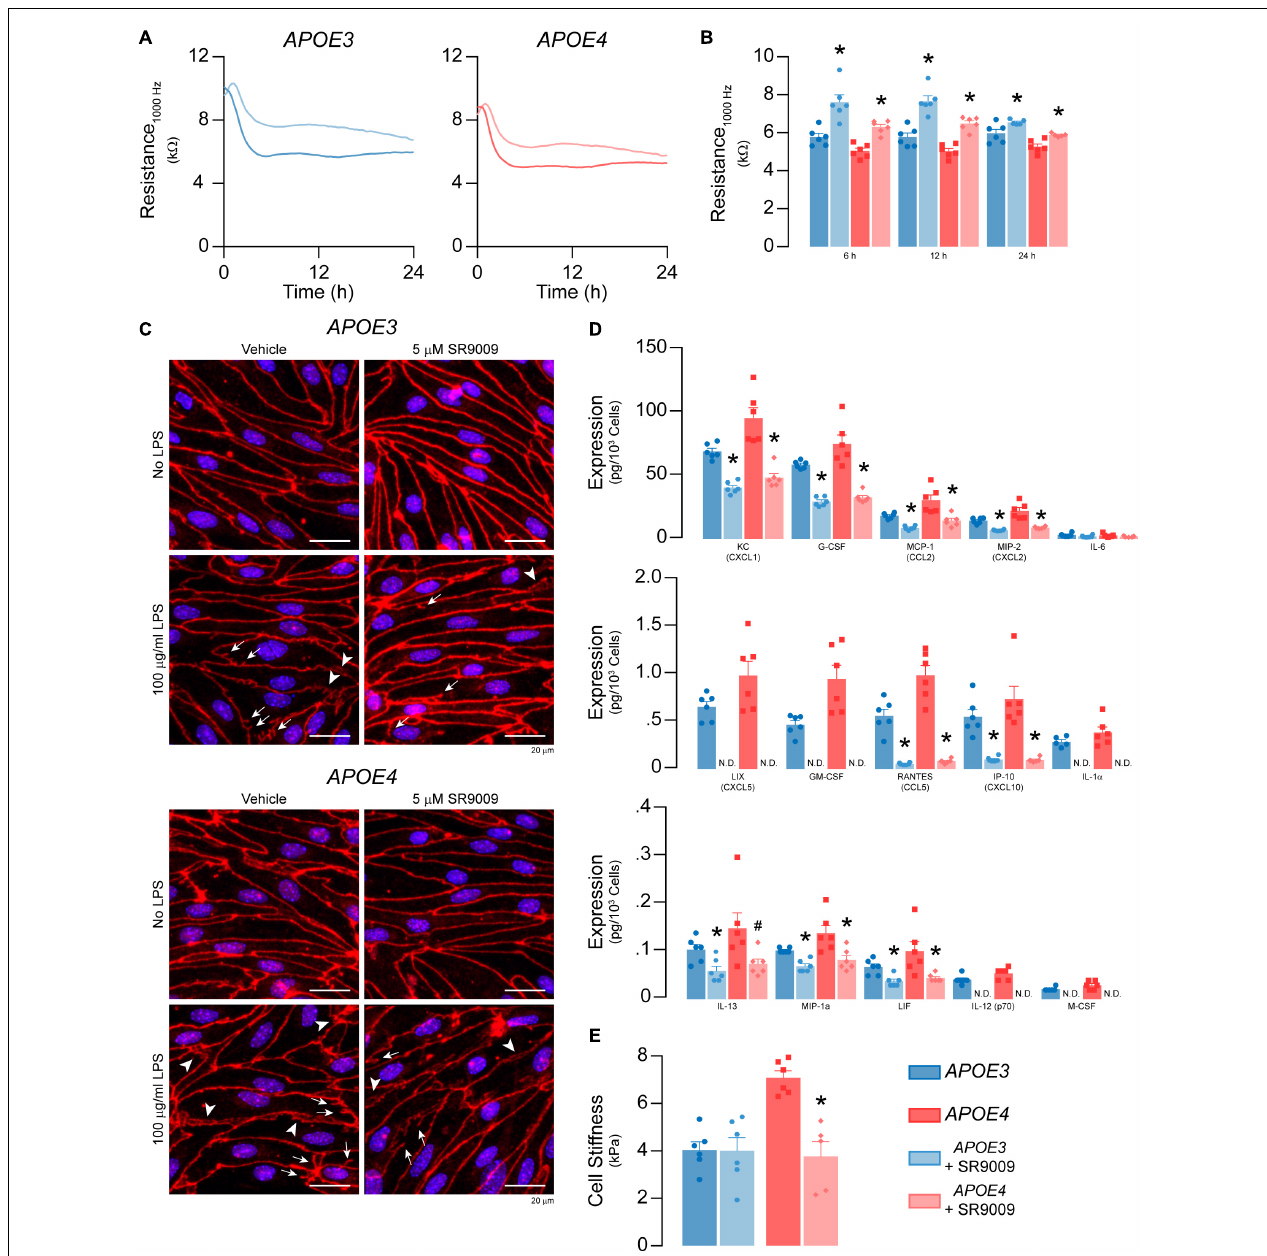
FIGURE 11 | SR9009 mitigates the effects of LPS on metabolism and inflammation in APOE4 brain endothelial cells. Confluent cells were treated with 5 µ M SR9009 for 48 h and LPS was spiked into the media 24 h prior to assays. SR9009 treatment mitigated 100 µ g/ml LPS-induced disruption of (A,B) paracellular permeability ( APOE3 vehicle n = 5, APOE4 SR9009 n = 5, all other groups n = 6) and (C) changes in tight junction morphology. In cells treated with 100 ng/ml LPS, SR9009 treatment results in (D) lower levels of chemokines and cytokines for both APOE3 and APOE4 (multiplex ELISA) and (E) lower cell stiffness (analyzed by paired t -test, n = 5 for APOE4 SR9009, all others n = 6), Data is expressed as mean ± S.E.M. * p < 0.05 by two-tailed Student’s t -test and # p < 0.05 by one-tailed Student’s t -test compared to vehicle control with n = 6 (unless otherwise specified